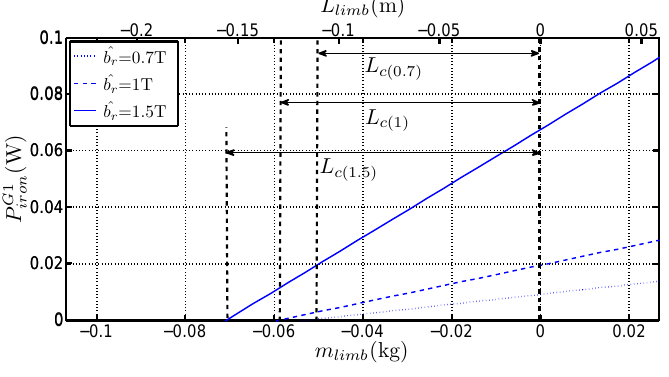
Figure 11. Variations of P iron with L limb for ˆ b = 0.7T, ˆ b = 1T and ˆ b = 1.5T for G1 grade.